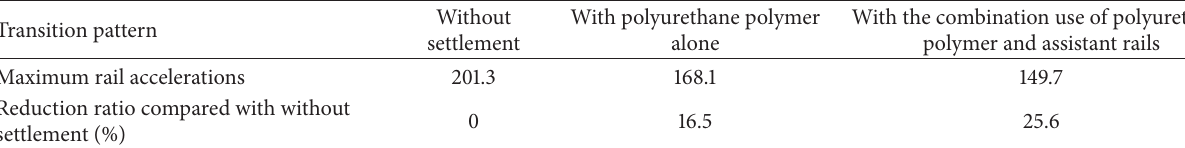
Table 4: Maximum rail accelerations and reduction ratios for different transition patterns.